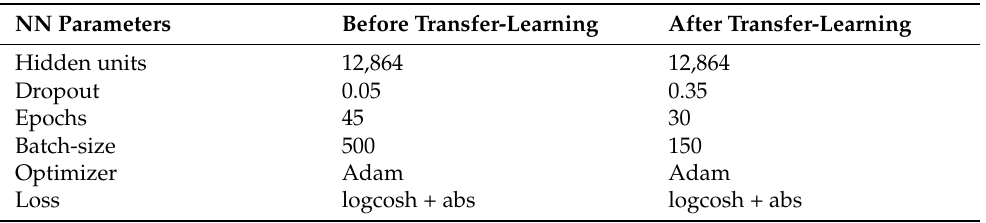
Table 2. The final architectures of the Differential Siamese Network before and after transfer learning. The optimal parameters were selected on a validation set without intersections with the training set. NN Parameters Before Transfer-Learning After Transfer-Learning Hidden units 12,864 12,864 Dropout 0.05 0.35 45 30 500 150 Adam